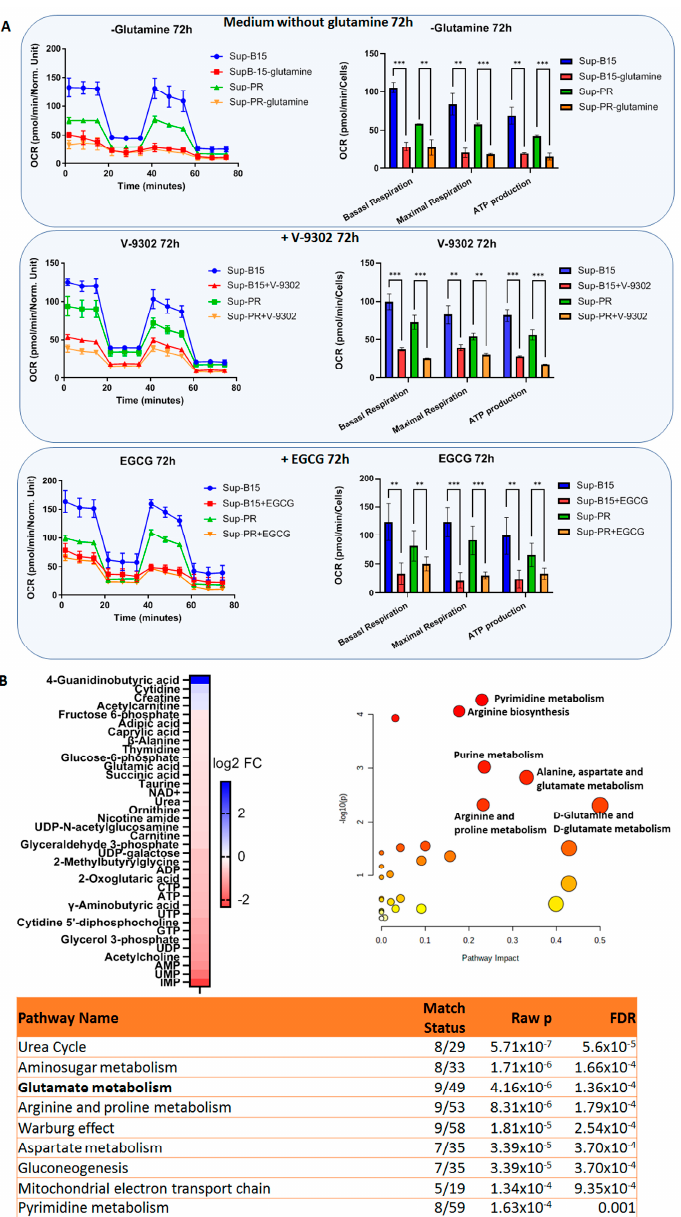
Figure 4. Inhibition of glutaminolysis impairs mitochondrial function. ( A ) Seahorse analysis of mitochondrial function showing oxygen consumption rates (OCR) in a Seahorse mito stress test (left hand side), and the relevant quantification (right hand side) of basal and maximal respiration and ATP production, as annotated in cells grown in a medium without glutamine (top panel), or treated with V-9302 (middle panel) or EGCG (bottom panel) for 72 h. Error bars represent the mean with SD from biological duplicates. **— p < 0.005, ***— p < 0.005 Student’s t -test. ( B ) Metabolite analysis of Sup-PR and Sup-B15 cells treated with EGCG compared to control untreated samples of the two cell lines, showing a heatmap of the up- and downregulated metabolites after treatment for 16 h (left hand side), as well as pathway analysis (right hand side) and a list of the top enrichment terms from a MSEA (bottom).